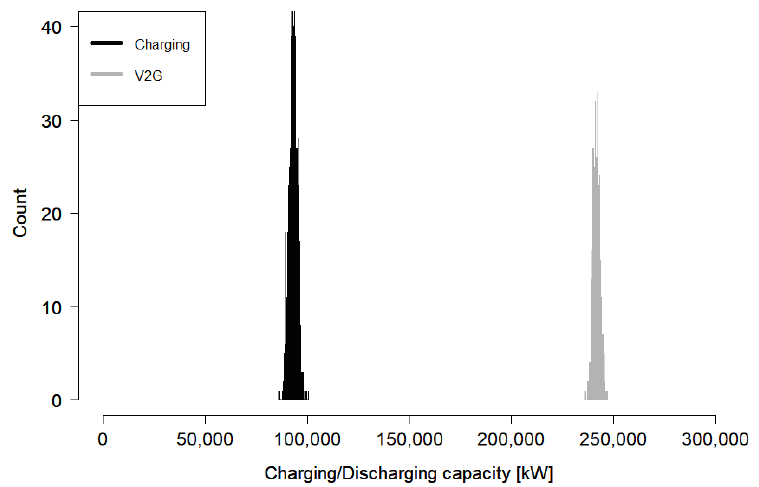
Figure 8. Result of EV charging and V2G discharging capacity distribution for Jeju at peak time in 2030 obtained from Monte Carlo simulation.